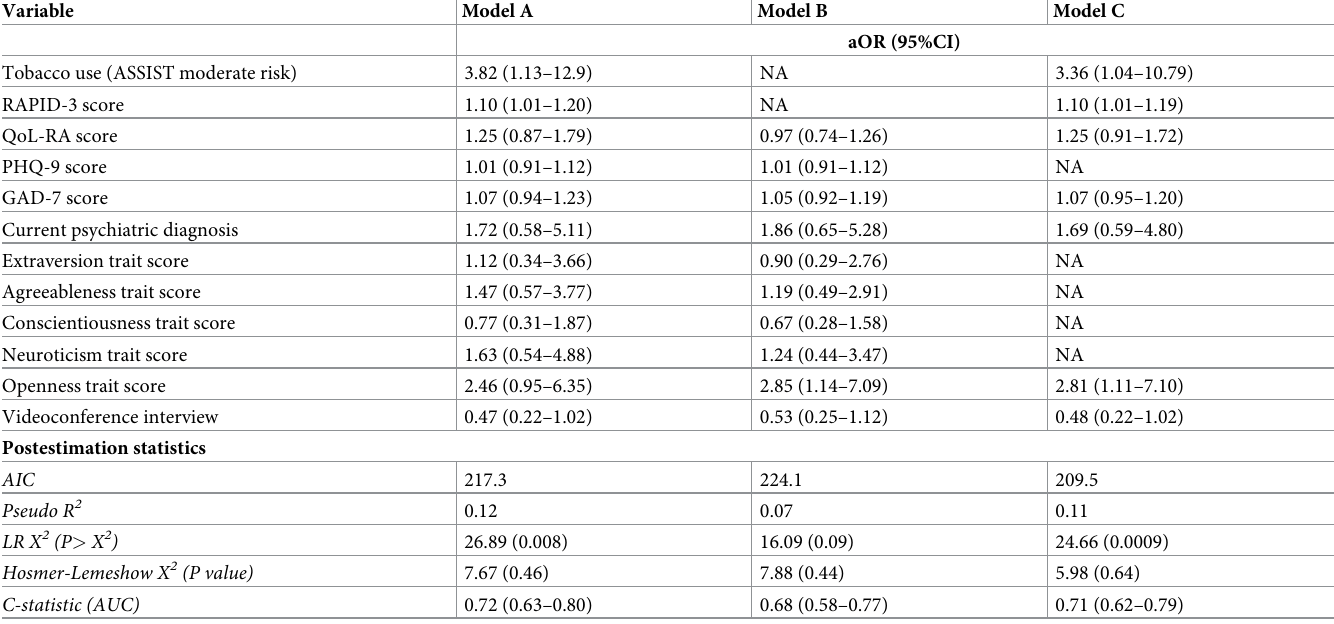
Table 3. Multivariable logistic regression models for medicinal cannabis use on rheumatoid arthritis patients.